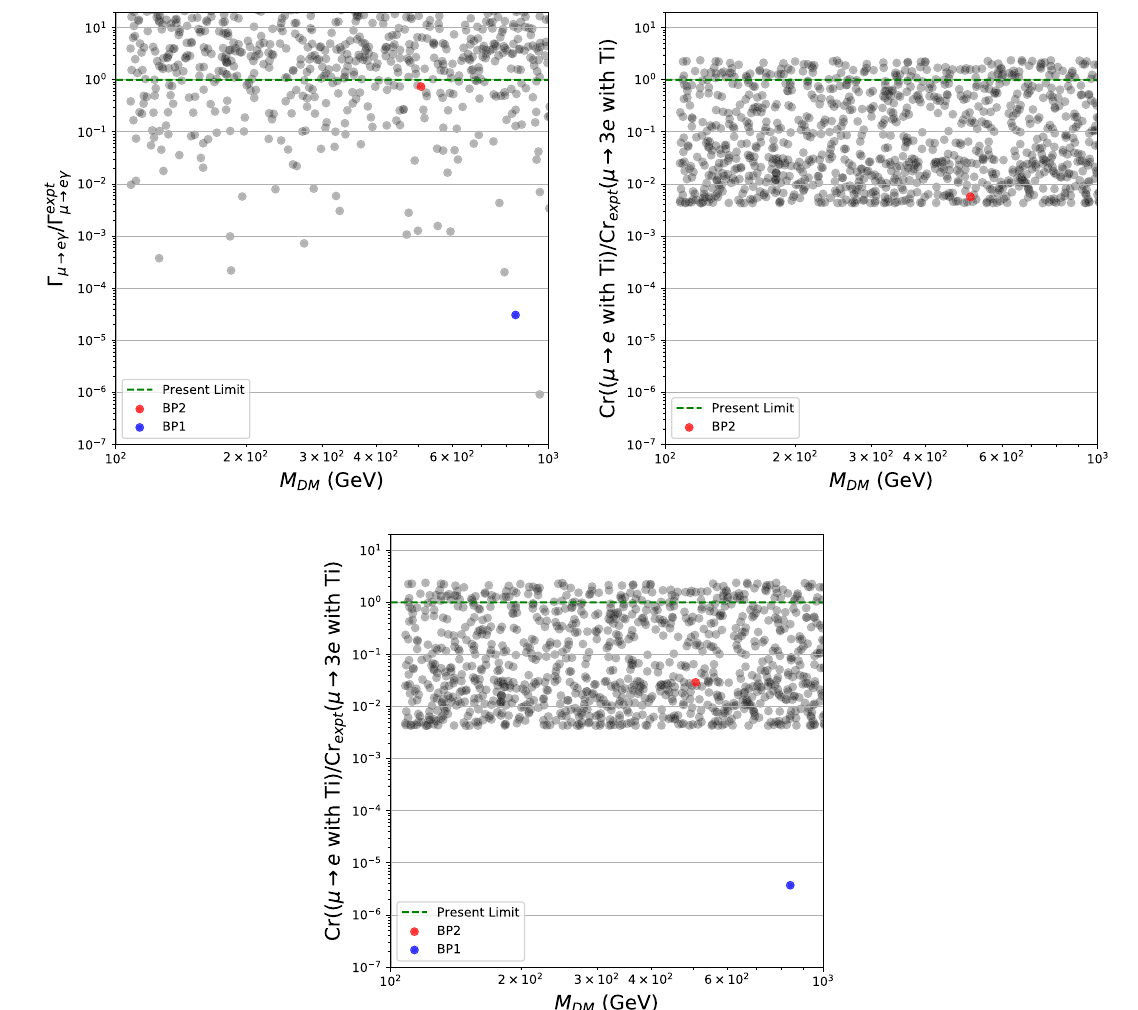
Fig. 7 Predictions for LFV processes for 10 2 GeV < M DM < 10 3 GeV. The two benchmark points are highlighted with red and blue coloured points. The μ η are varied from 100 GeV to 1 TeV, and the other parameters are taken as presented in Table